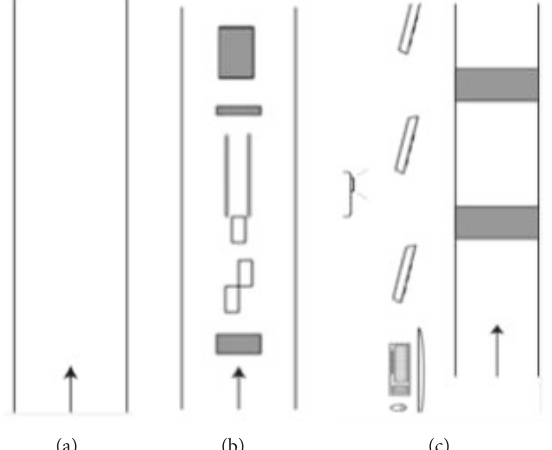
Figure1:Schematicrepresentationsofthethreewalkingenvironments.(a)Plainwalkingenvironment.(b)Challengingwalkingenvironment with stationary physical context (challenging-physical; comprising three stepping targets, a 2-m tandem-walking path, and three obstacles). (c) Challenging walking environment with suddenly appearing projector-augmented context (challenging-projected; comprising position- dependent and gait-dependent